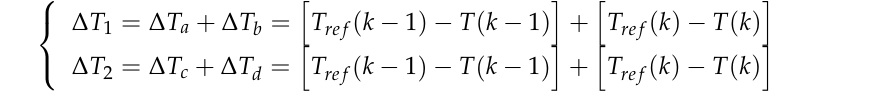
where and are the total torque errors in region 1 and region 2, respectively; T Δ and T Δ are the torque errors of the outgoing phase in region 1 and region 2, re- a d T Δ and T Δ are the torque errors of the incoming phase in region 1 and re- spectively; b c ) 1 T k − is the torque reference of the outgoing phase, is gion 2, respectively; ref the torque of the outgoing phase, k is the torque reference of the incoming phase, ( ) T k is the torque of the incoming phase. It can be seen from Formulas (5), (7) and (8) that ( ) 1 ref T k −